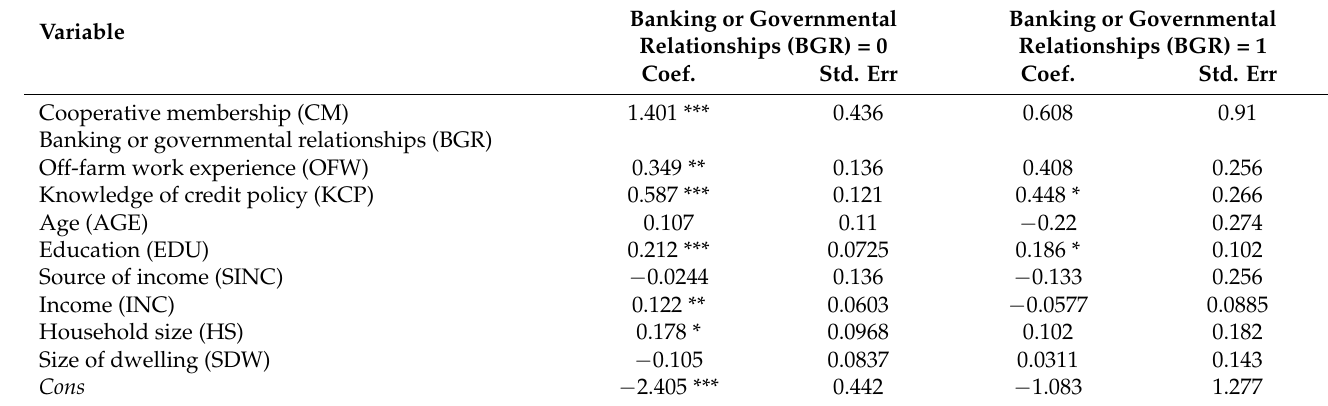
Table 5. Heterogeneity in the loan availability of cooperative membership by BGR.